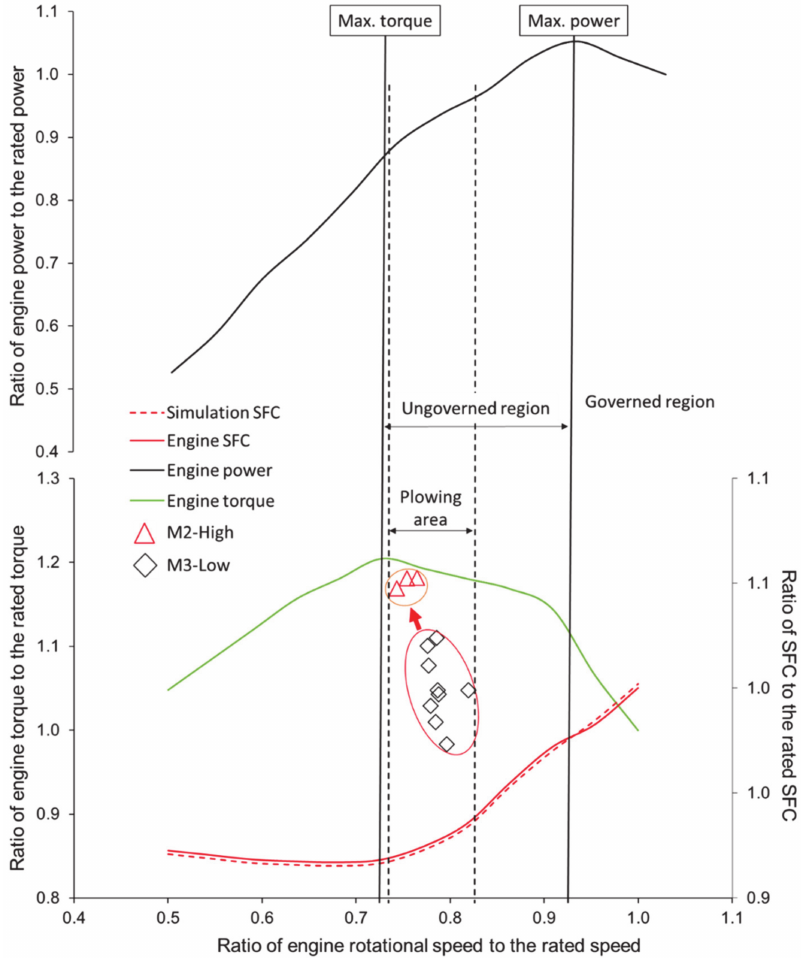
Figure 11. The engine performance curve at engine full load